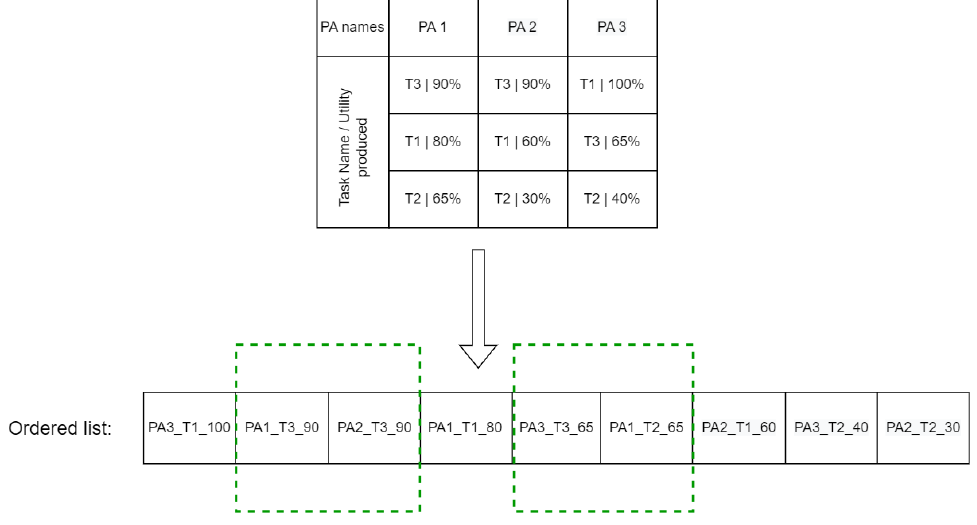
Figure 5. The first step of the agents preferences distribution